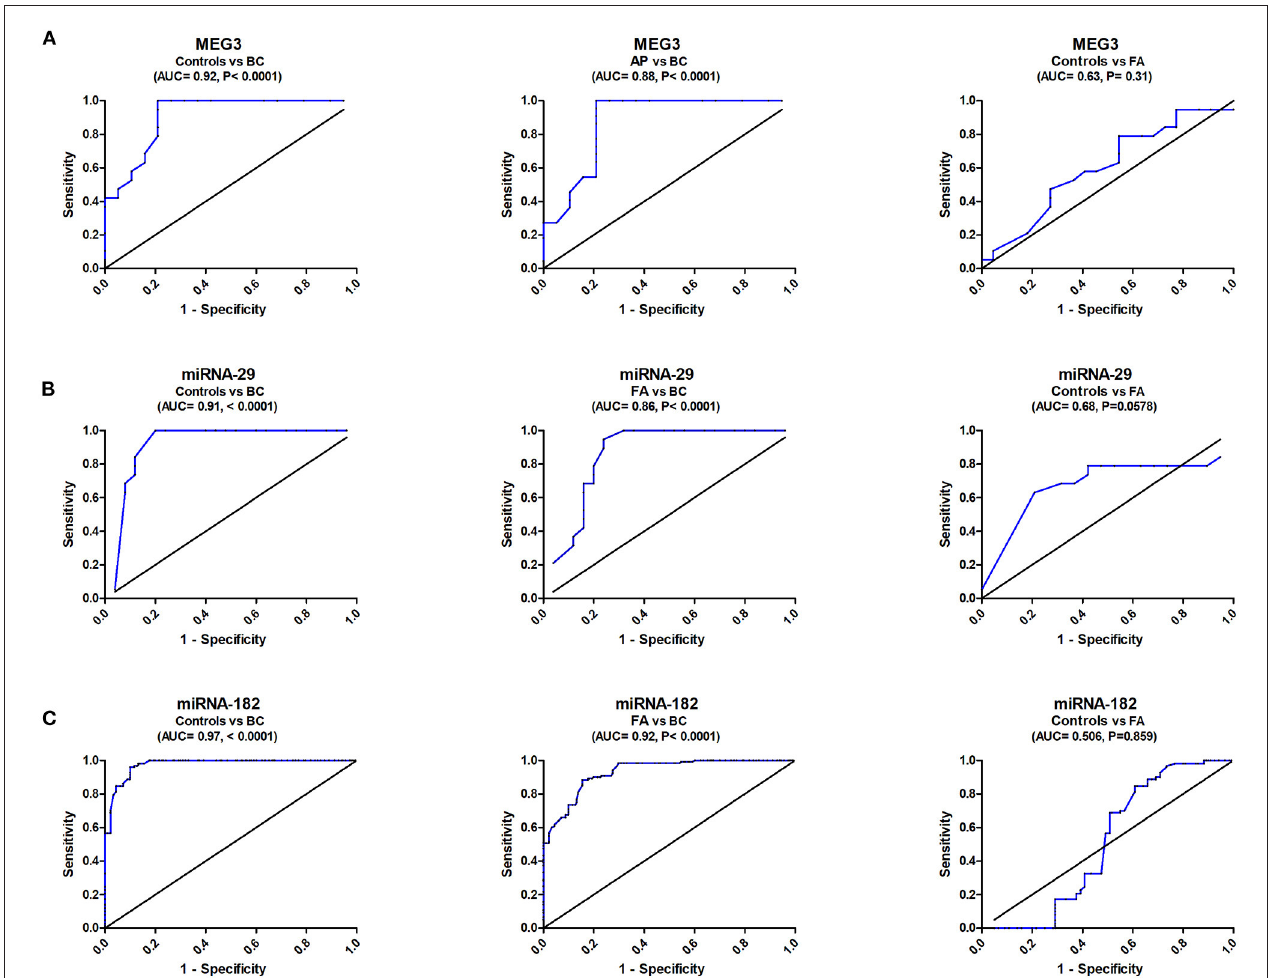
FIGURE 2 | ROC curve study of serum MEG3, miRNA-29, and miRNA182 to differentiate the studied types, BC ( n = 180) and FA ( n = 120), from controls ( n = 150). (A) Diagnostic accuracy of serum MEG3, (B) Diagnostic accuracy of serum miRNA-29, and (C) Diagnostic accuracy of serum